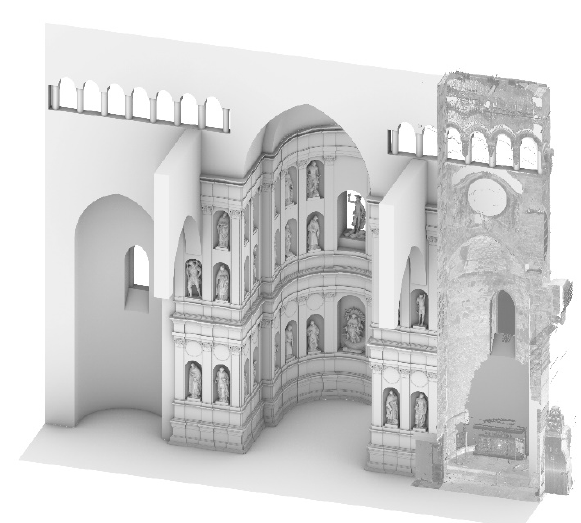
Figure 6 . Axonometric view of the reconstruction model of the Tribuna.